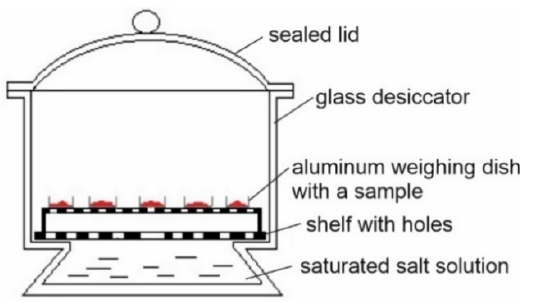
Figure 2. Sorption isotherms—the experimental set up of static method. Modelling of Moisture Sorption Isotherms